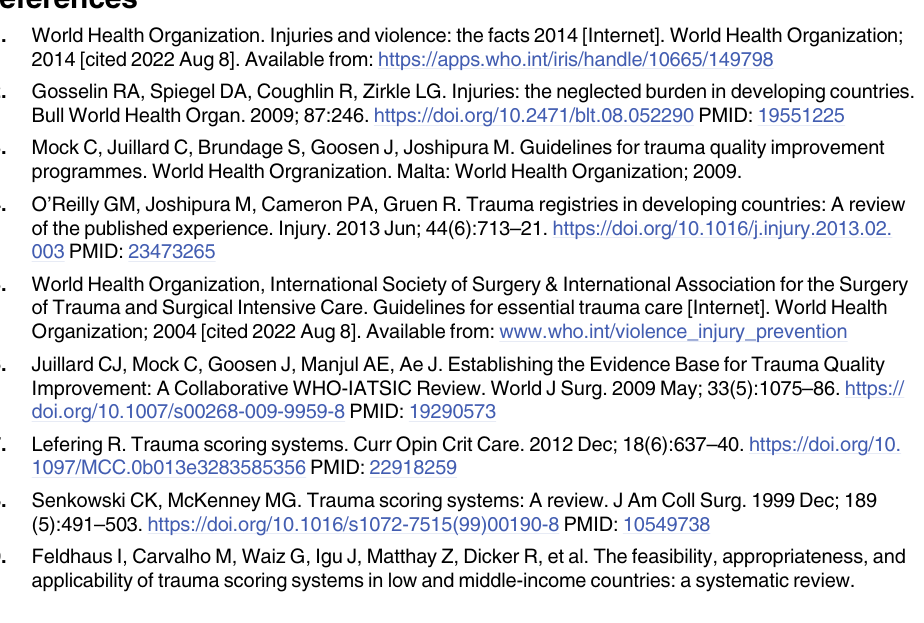
S1 Table. Injury severity, mechanism, and disposition outcomes by sex. S2 Table. Logistic regression of disposition